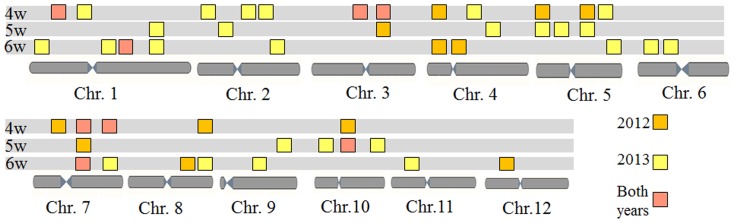
Temporal dynamics of additive QTL at 4, 5 and 6 weeks after heading in 2012 and 2013.